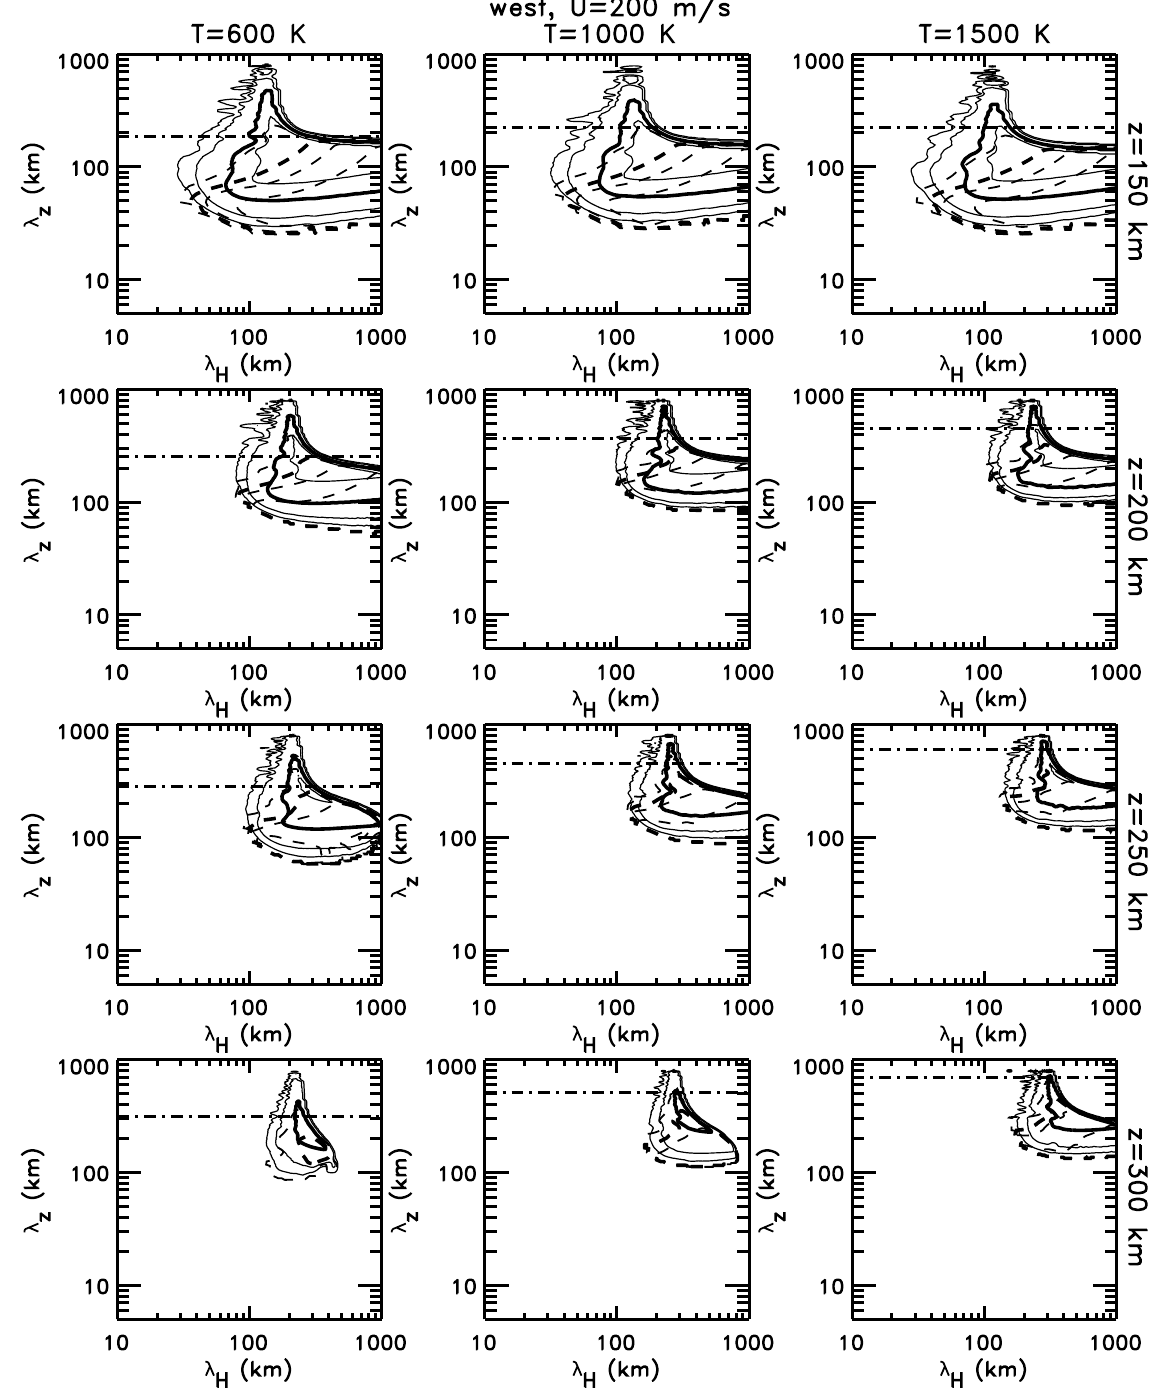
Fig. 9. As in Figs. 6 to 8, but for westward-propagating (up-shifted) GWs for minimum, mean, and maximum solar forcing (left, middle, and right columns, respectively) with an eastward thermospheric wind of 200ms − 1